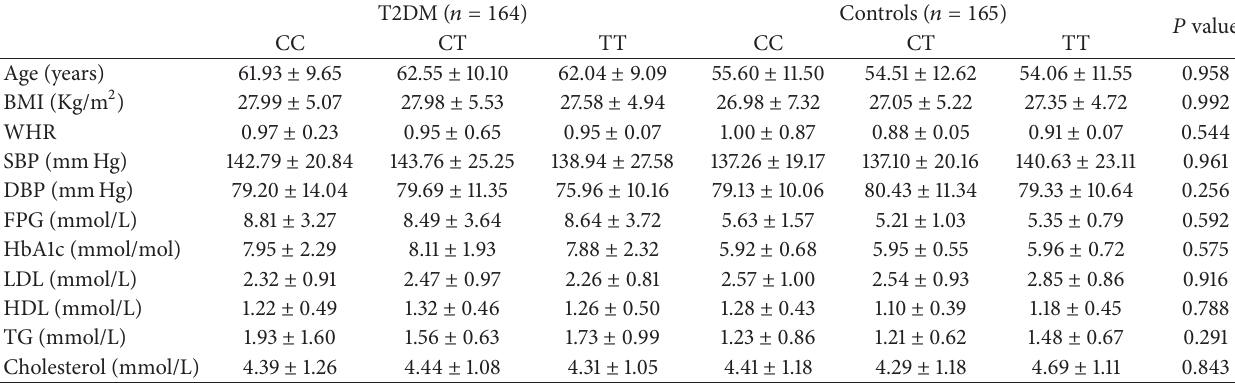
Table 4: Clinical and biochemical characteristics among subjects according to genotypes of C69T.